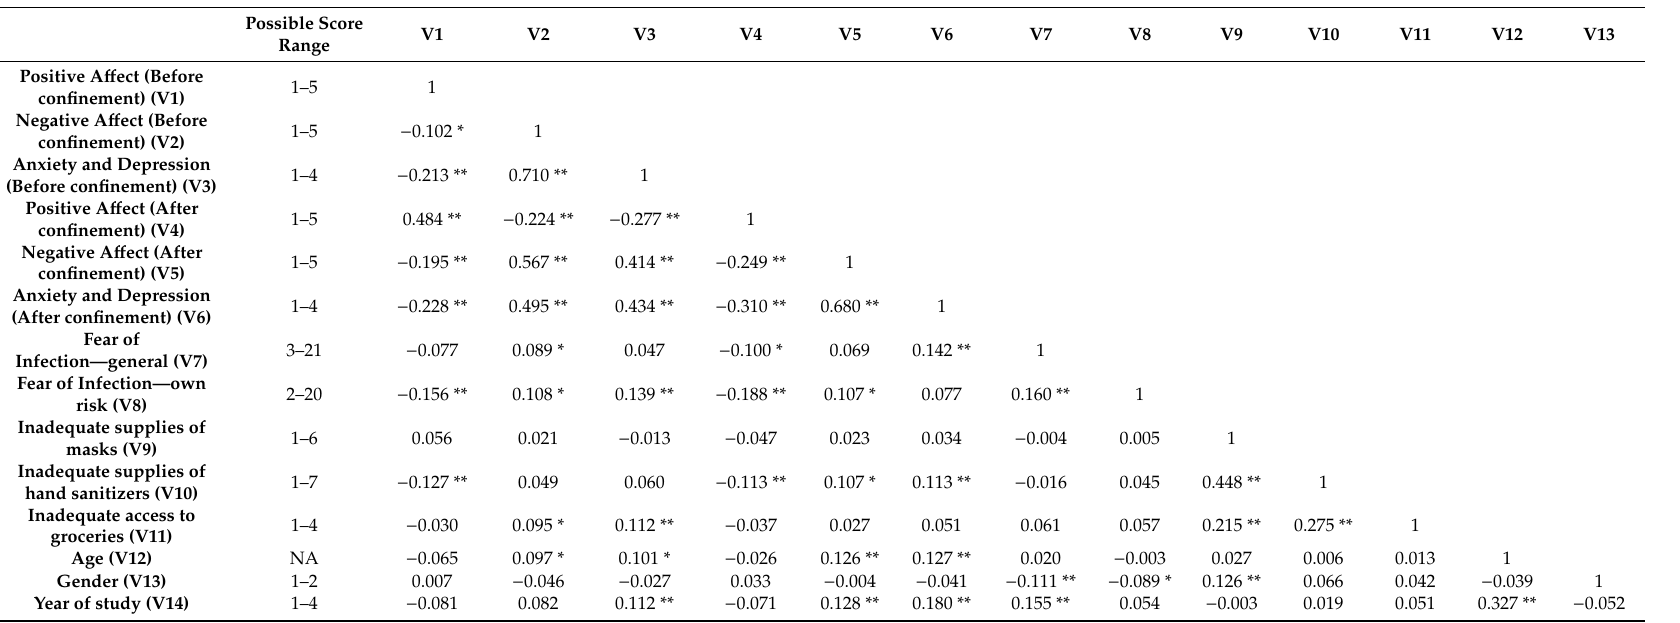
Table 2. Correlations among the studied variables ( n =